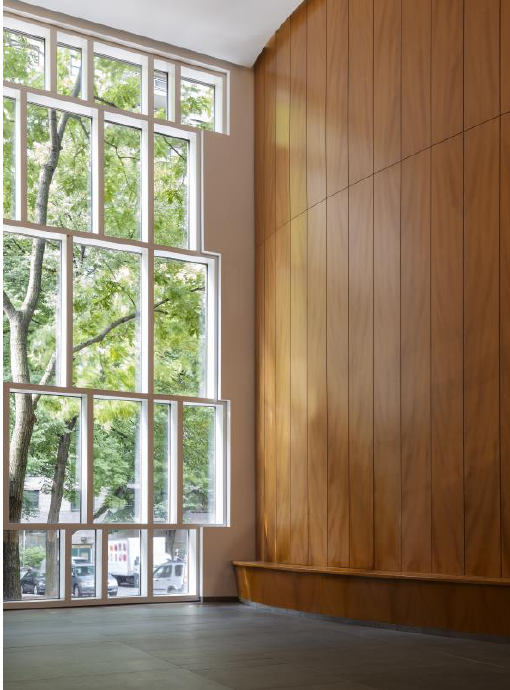
Figure 7. West window, and part of north wall of cedar. Photo David Sundberg/ESTO.